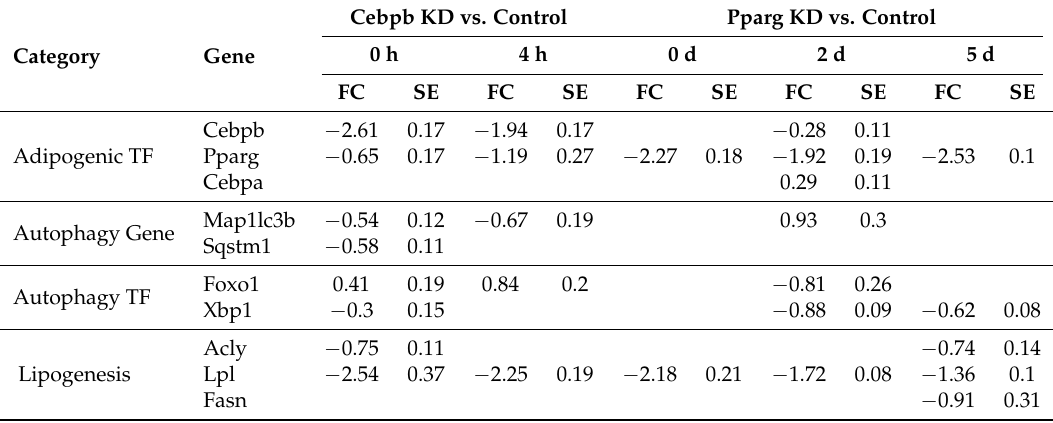
Table 2. Significant differentially expressed genes in Cebpb or Pparg knockdown adipocytes. KD, knockdown; h, hour; d, day; FC, fold-change; SE, standard